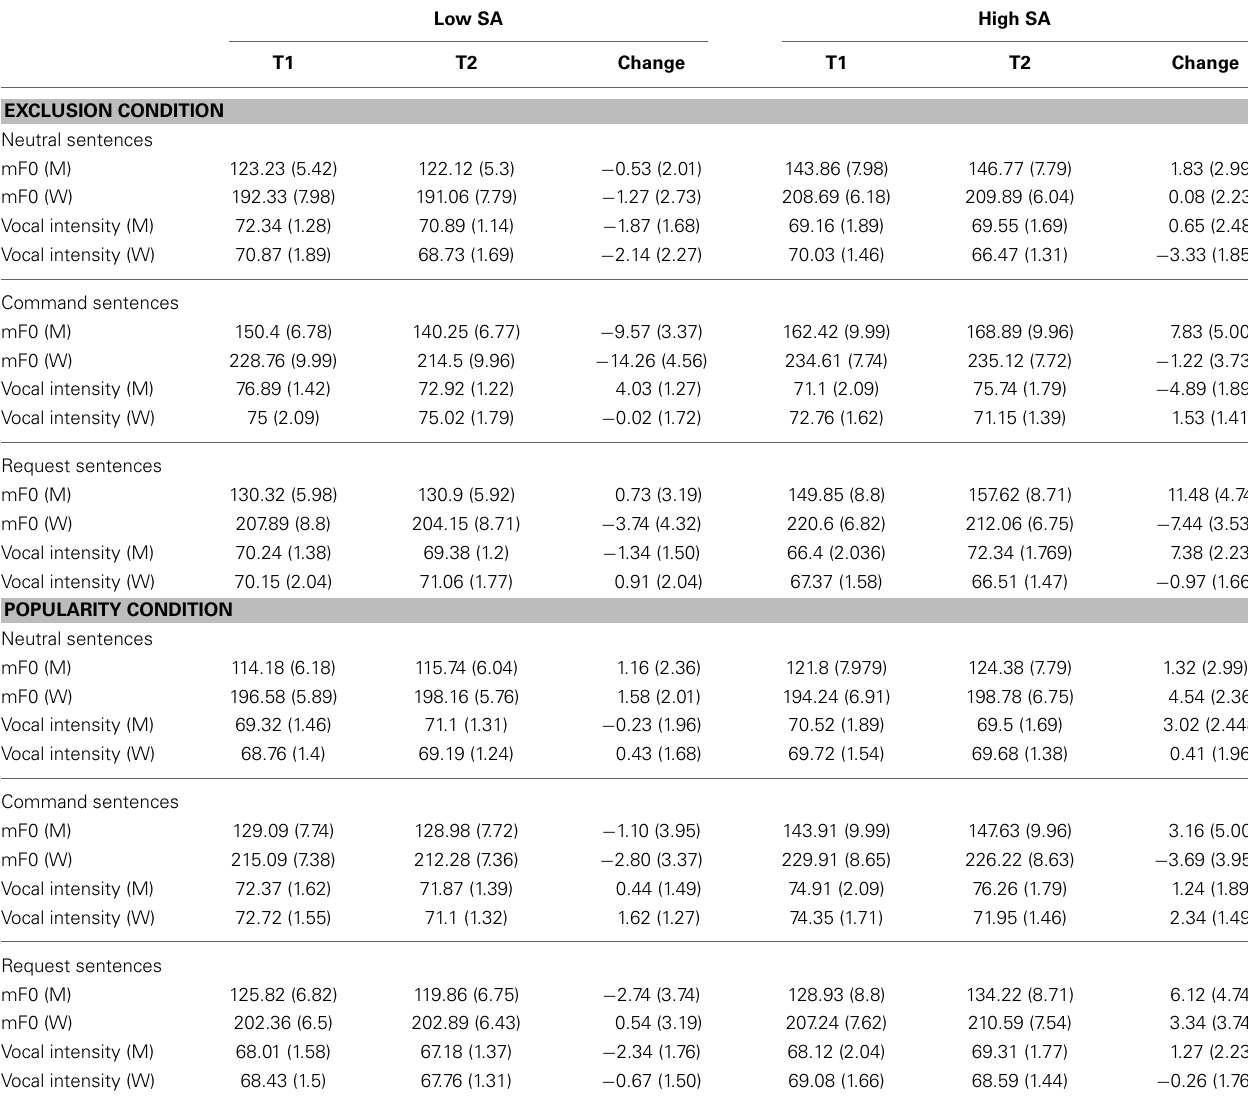
Table 2 | Means and standard deviation (in parentheses) of acoustic parameters recorded after exclusion and popularity conditions according to social anxiety (SA) group and